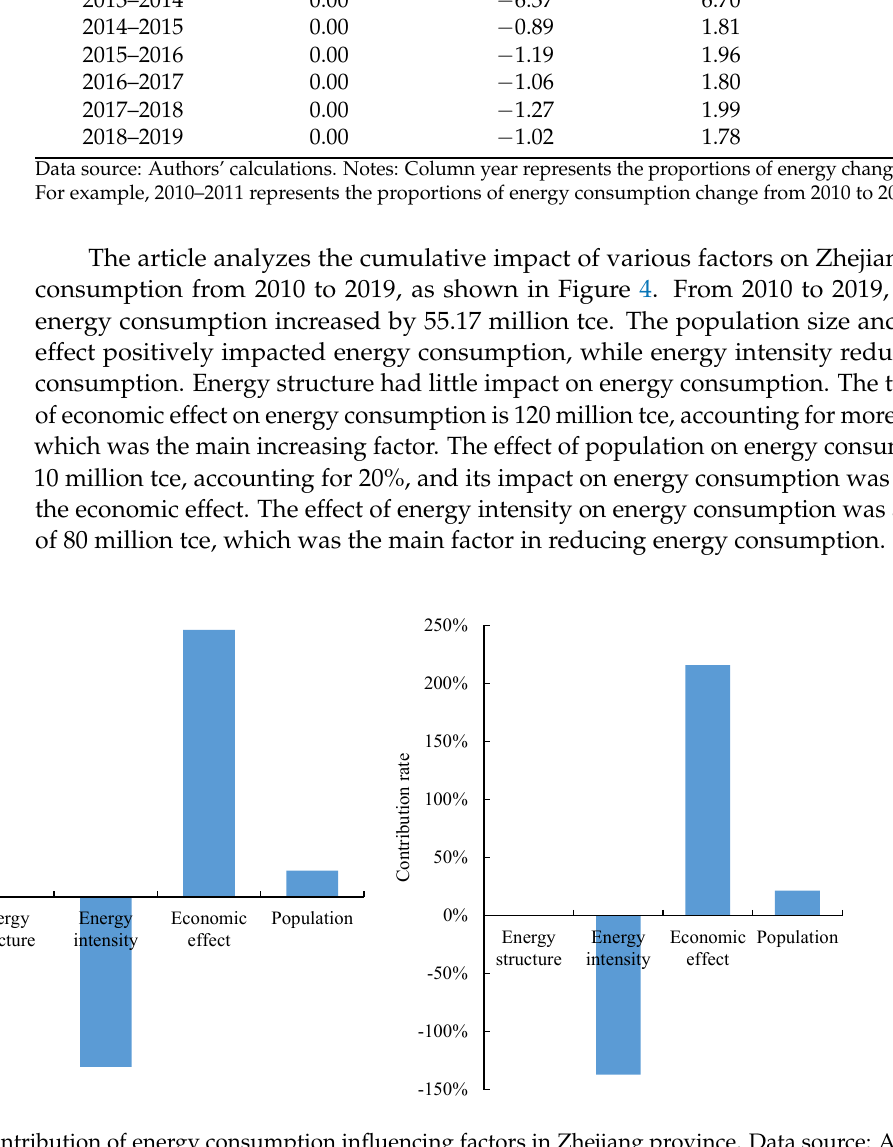
Figure 5. Decomposition results of energy consumption per unit of added value in major industrial sectors in Zhejiang (2015–2020). Data source: authors’ calculations.